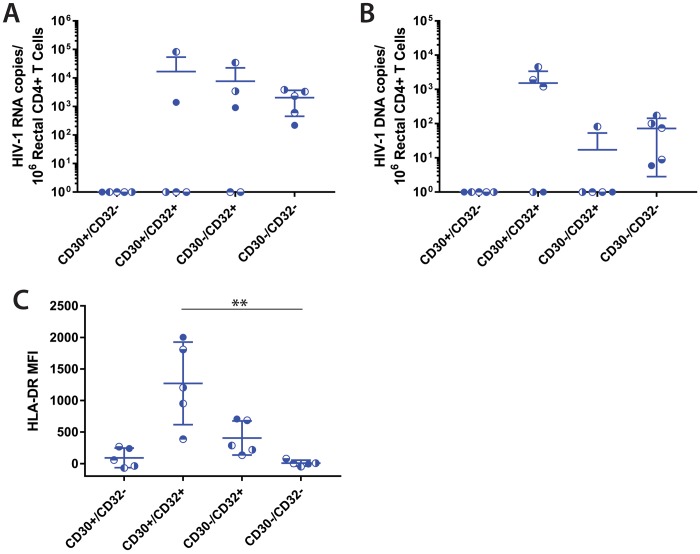
HIV-1 RNA and DNA quantification in rectal tissue-derived CD4+ T cell subsets.HIV-1 RNA and DNA levels for each CD4+ T cell subset (based on co-expression of CD30 and CD32) are shown in A and B, respectively. (C) A significantly higher mean HLA-DR MFI was observed in CD30+CD32+ cells compared with CD30-CD32-CD4+ T cells (P = 0.004 by Friedman test with Dunns correction for multiple comparisons). In contrast, no significant intergroup differences were observed in cell-associated HIV-1 RNA or DNA between cohorts. Bars represent mean ± standard deviation.